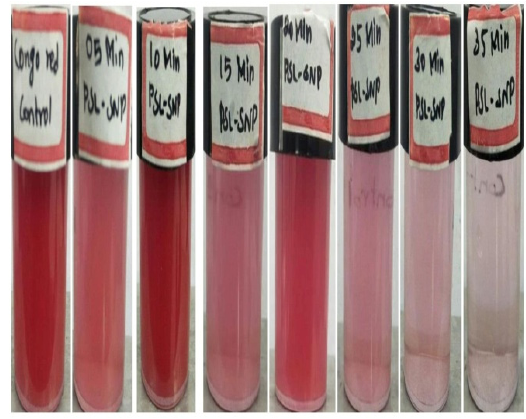
Fig.11. Congo red dye degradation of Pogostemon speciosus SNPs at various time